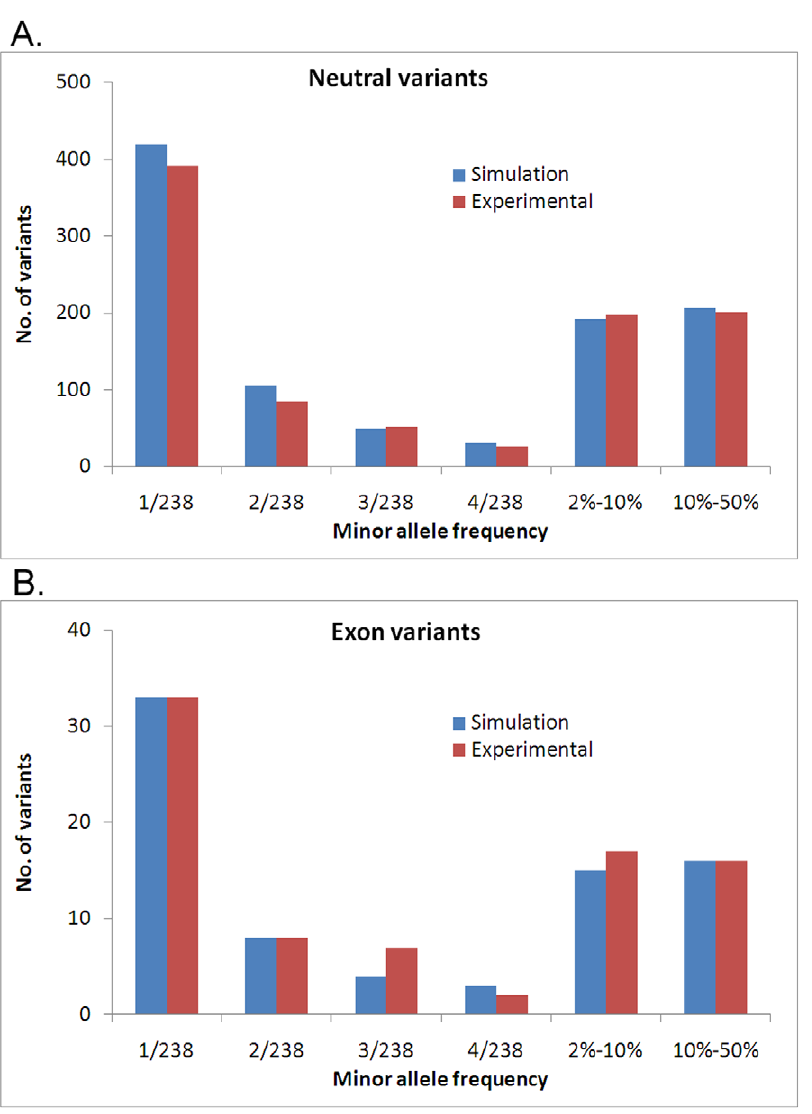
Figure 3. Fitness of simulated variants to experimental variants. The fitness of allele frequencies simulated by the demographic model to that of experimental data for neutral variants ( A ) and coding variants ( B ).